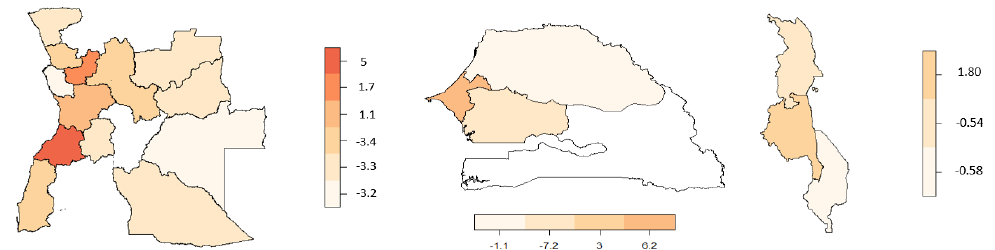
Figure 4. Estimated effect of the structured spatial effect on malnourishment. ( Left ) Angola, ( middle ) Senegal, and ( right ) Malawi.